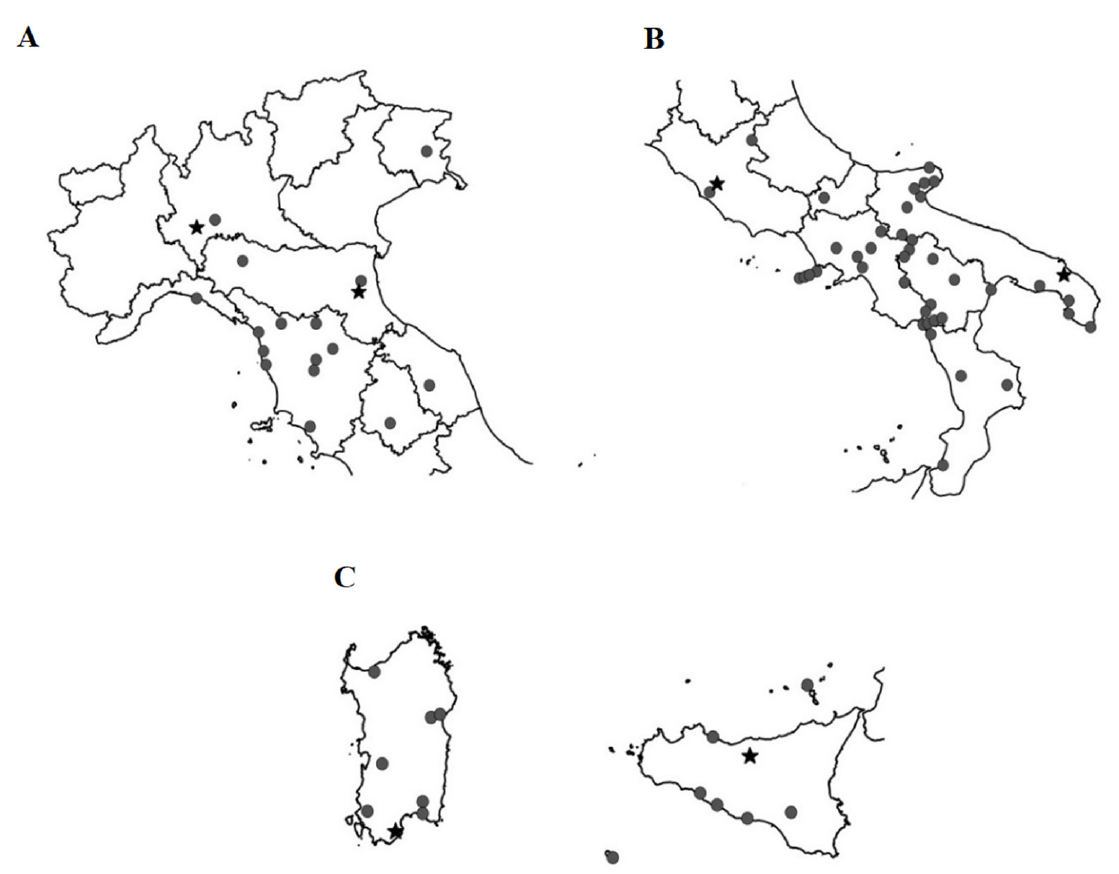
Figure 5. Italian localities where specimens of R. lucifugus were collected. ( A ) Northern Italy. ( B ) Southern Italy. ( C ) Sardinia, Sicily and minor islands. Stars, laboratory specimens; Circles, specimens collected in the wild.